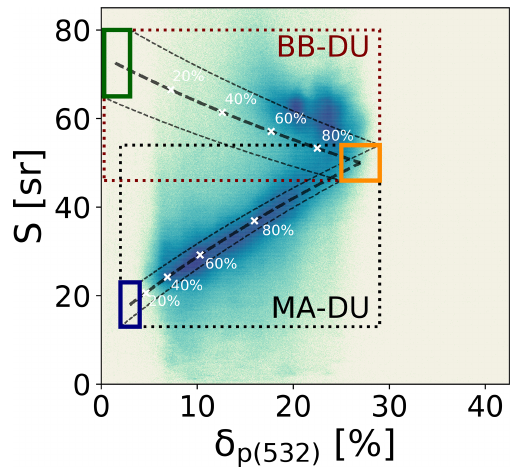
Figure 6. Two-dimensional histogram showing the joint distribu- tion of measured particle linear depolarization ( δ p ) and lidar ratios ( S ) during the three research flights over long-range-transported Sa- haran mineral dust. Solid rectangles mark the typical positions of the pure aerosol regimes: marine aerosol (MA, blue), transported Saharan mineral dust (DU, orange) and biomass-burning aerosol (BB, green). The dashed rectangles indicate the mixing regimes of biomass-burning aerosols with transported Saharan dust aerosols (BB-DU, maroon) as well as of marine aerosols with transported Saharan dust aerosols (MA-DU, blue). Gray lines indicate the cal- culated mixing lines (dashed: mean, solid: ± standard deviation) of the two aerosol mixtures MA-DU and BB-DU. White crosses and percentages indicate the contribution of dust to δ p of the respective two-component mixtures. The histogram is normalized to the max- imum bin